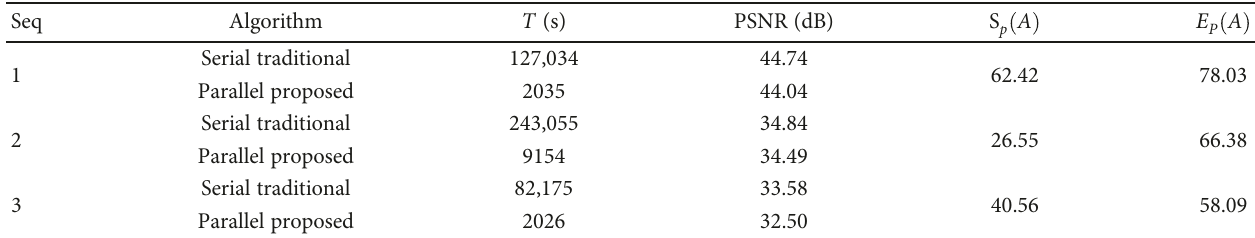
Table 7: Comparison of performance of the traditional algorithm and the proposed algorithm.